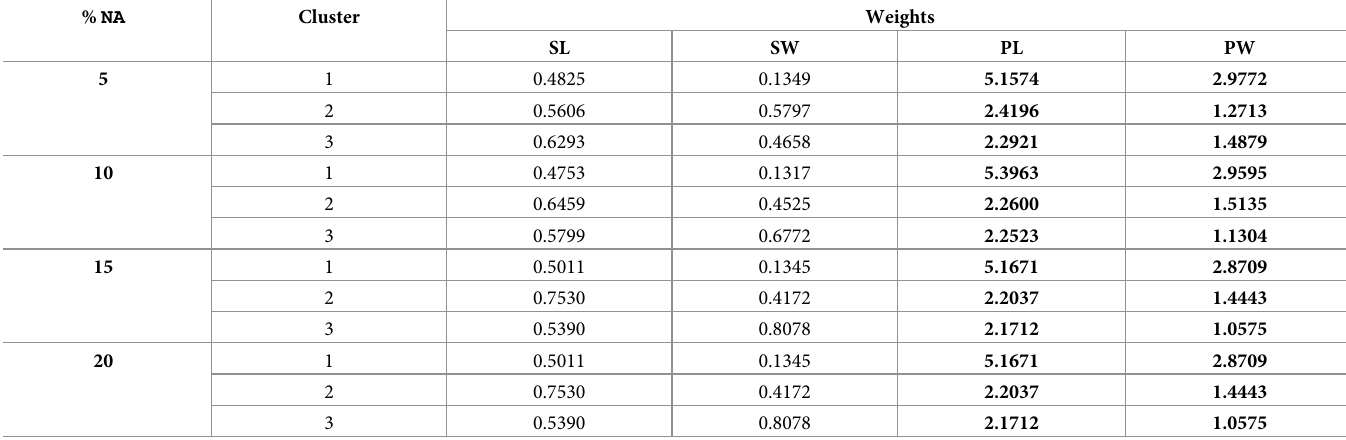
percentage of missing values in Cluster 2 for the PDS and OCS methods. This behavior is also observed for the weights of the PW variable in Cluster 1 in the PDS method. For the WDS strategy, as the percentage of missing values increases, variable PW becomes more relevant. Fig 4 shows the performance results of the OCS, PDS and WDS algorithms in the 100 Monte Carlo repetitions. The WDS strategy had the largest deviations in error rate when com- pared to the others. For the PDS approach, increasing and decreasing average error rates were observed over the analyzed percentages. In the OCS strategy, there is an increasing error rate, starting from 10% of missing values. This method presents a more defined behavior, i.e. as the percentage of missing values increases, the error rate also increases. The OCS strategy showed the smallest deviations in relation to the average error rate when compared with the WDS and PDS strategies. Analyzing the measures of variable consistency from Table 6, considering the complete dataset obtained after clustering with the VKFCM-K-LP algorithm, together with the OCS strategy, we have that these measures are very close to zero. This shows a good quality in the